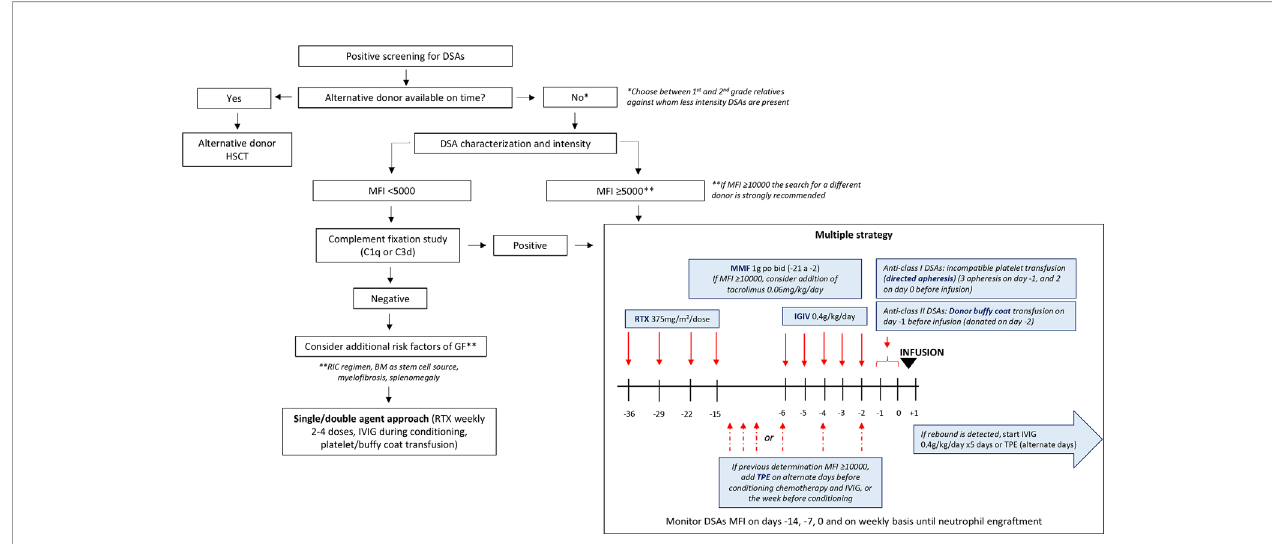
FIGURE 3 | Proposed algorithm for the monitoring and management of DSAs in haplo-HSCT; MFI, mean fl uorescence intensity; GF, graft failure; RIC, reduced intensity conditioning; BM, bone marrow; RTX, rituximab; IGIV, intravenous immunoglobulin; MMF, mofetil mycophenolate; TPE, therapeutic plasma